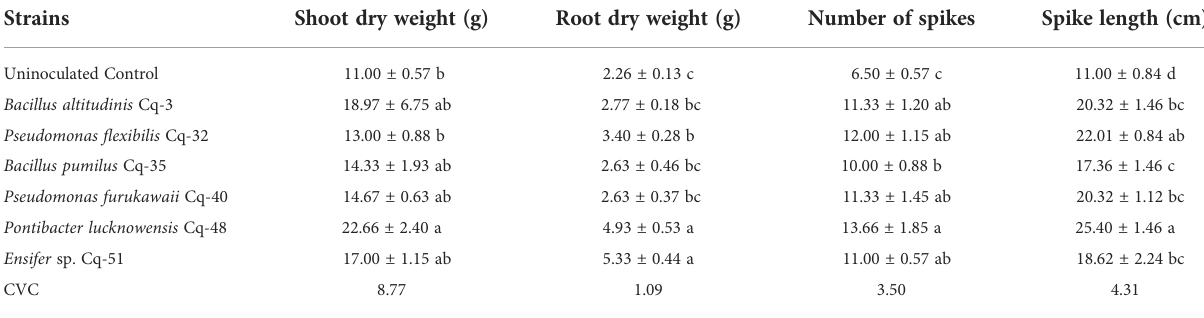
TABLE 8 Promotion of quinoa ’ s shoot weight, root weight, and spike growth through inoculation with phosphate solubilizing bacterial strains under pot trial. Strains